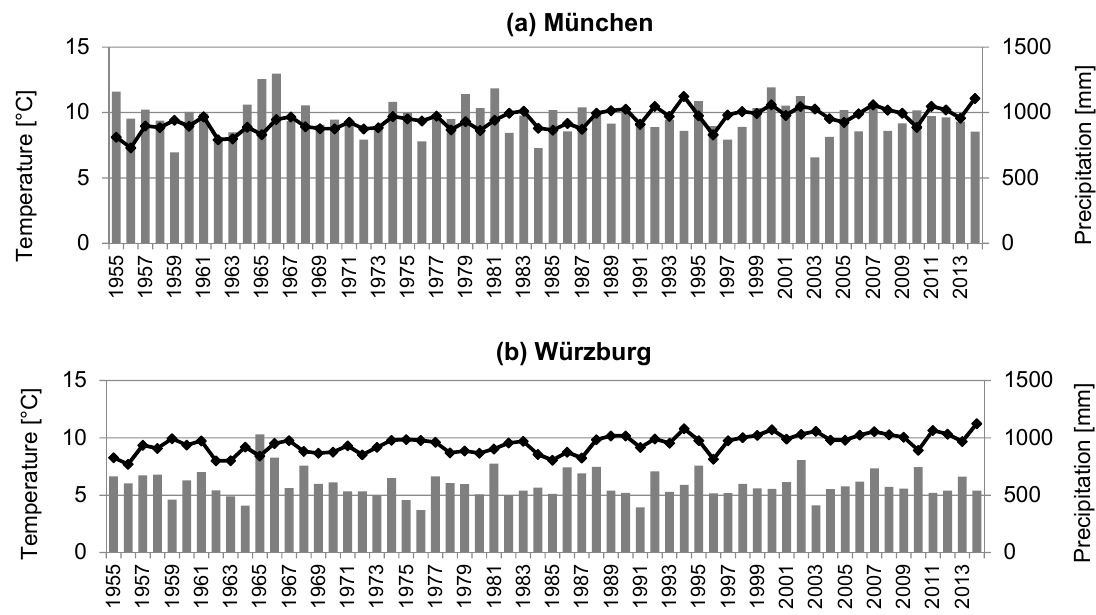
Figure 1. Climate graphs of München ( a ) and Würzburg ( b ) from 1955 to 2014 (data source: DWD [40]). Black dots and line represent the mean annual temperature in °C and the gray bars represent the annual precipitation in mm.